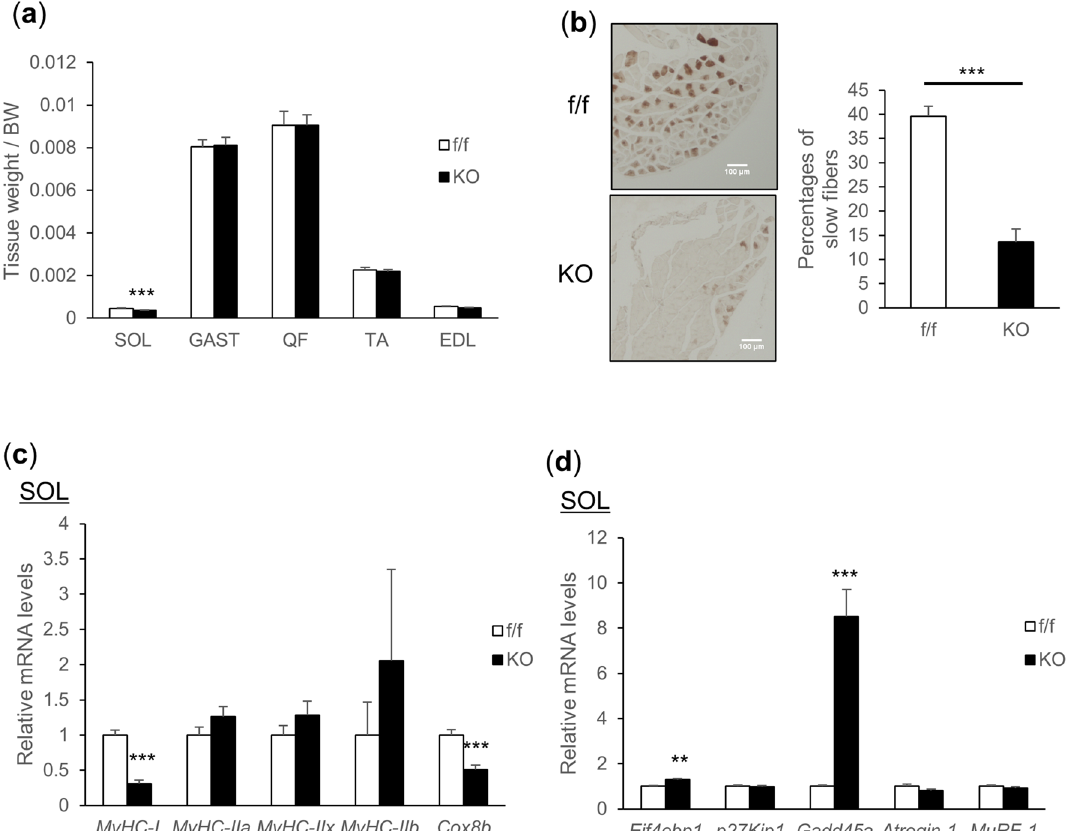
Figure 2. vMNTFG KO mice manifest muscle atrophy especially in slow-twitch fibers. ( a ) Muscle mass (bilateral) adjusted by body weight (7-month-old, n = 7–8). SOL: soleus, GAST: gastrocnemius, QF: quadriceps femoris, TA: tibialis anterior, EDL: extensor digitorum longus. ( b ) Representative immunostaining of SOL against myosin heavy chain (MyHC) type 1 (left panel) (scale bar: 100 µm) and the percentage of DAB-positive slow-fibers (right panel) (6-month-old mice, n = 5). ( c ) mRNA levels of each myosin-heavy chain (MHC) isoform and the mitochondrial gene Cox8b in SOL (7-month-old mice, n = 7–8). ( d ) mRNA levels of genes related to muscle atrophy in SOL (7-month-old mice, n = 7–8). (** P < 0.01, *** P <